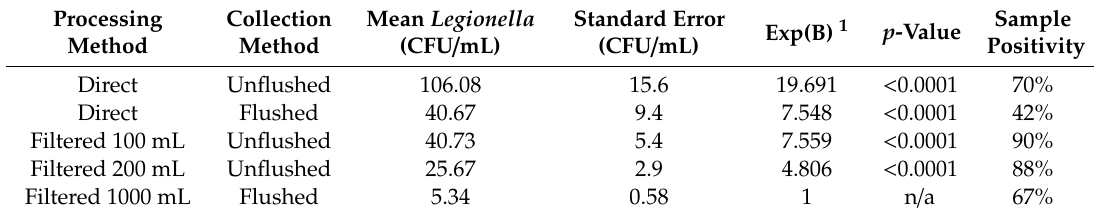
Table 2. Descriptive statistics of Legionella based on processing and collection method.